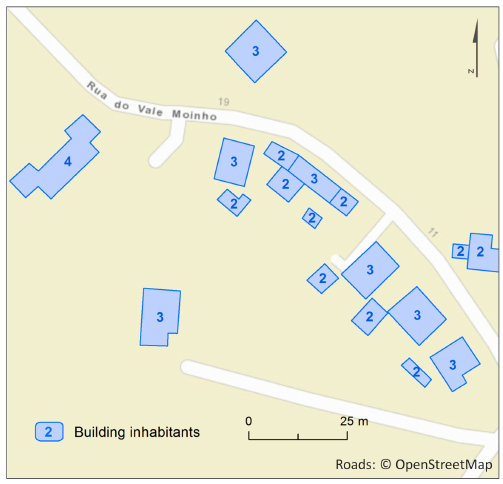
Table 2. Potentially exposed population per susceptibility class in